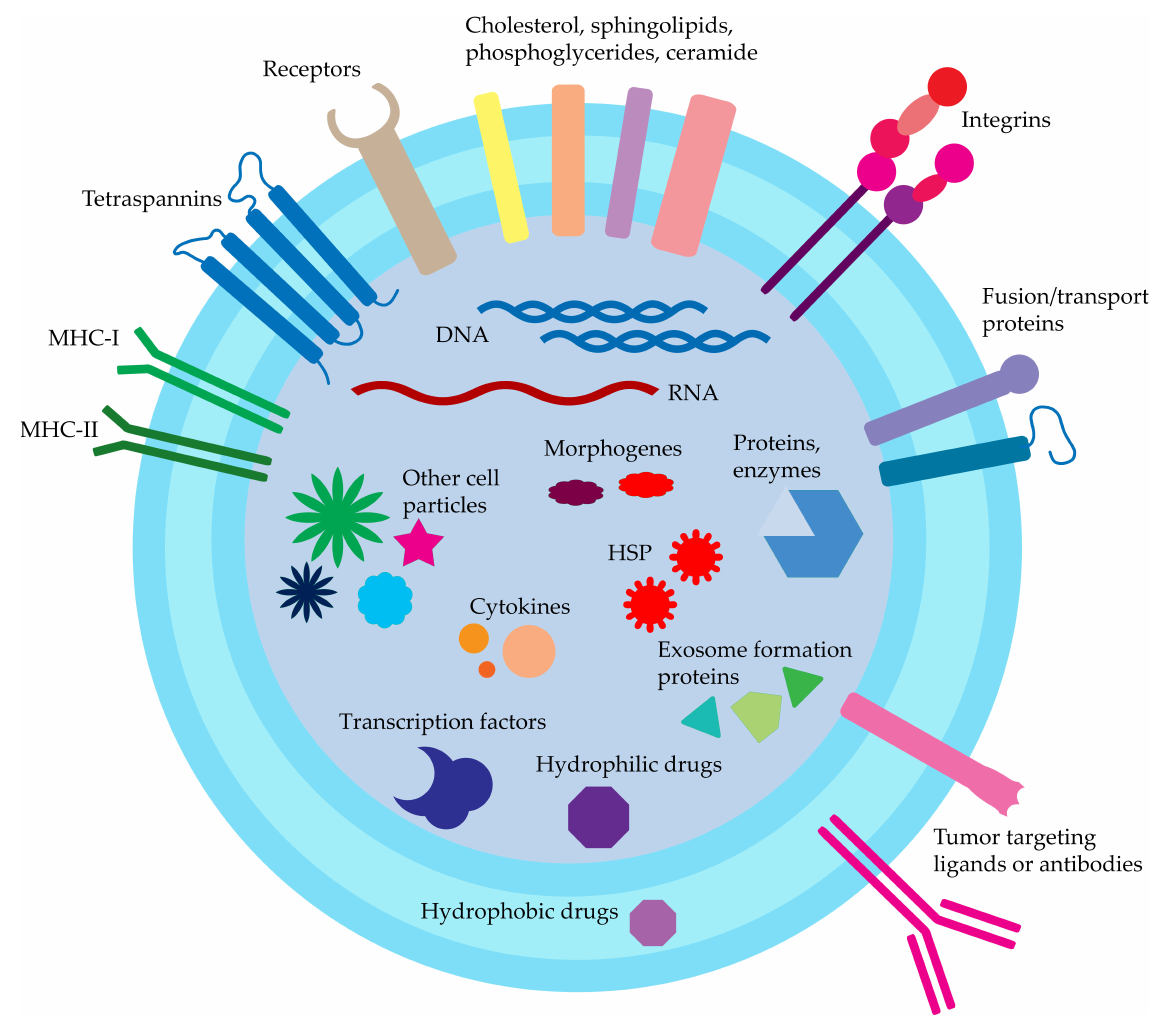
Figure 2. Exosomes structure and cargo. Table 2. Examples of miRNA-level changes proposed for diagnosing